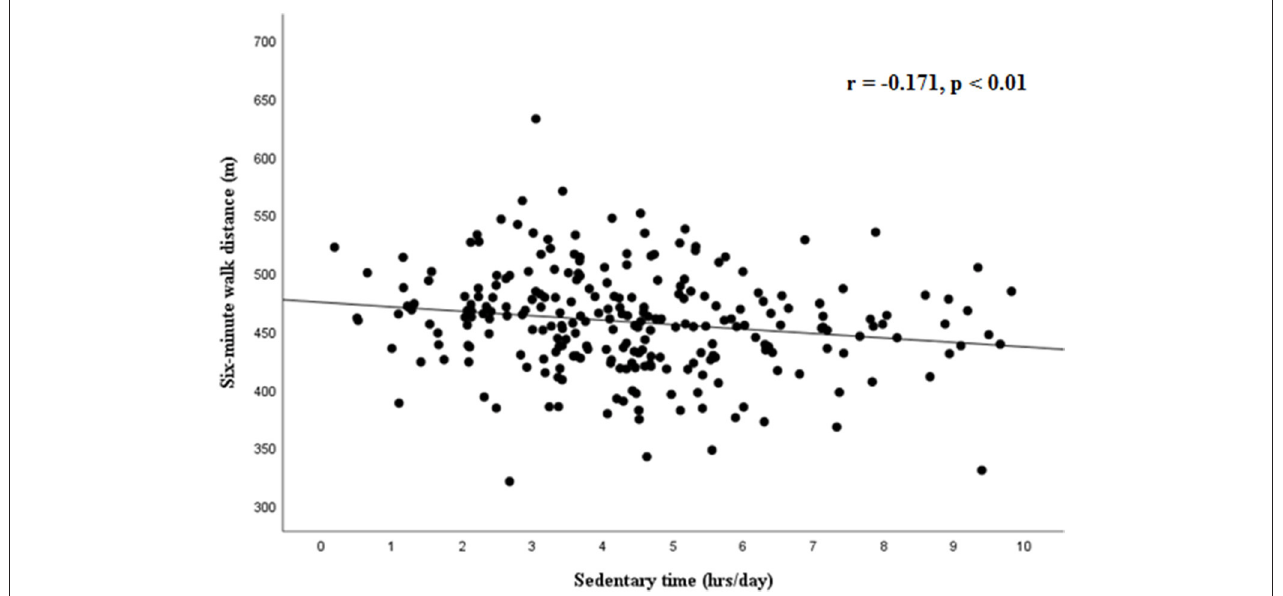
FIGURE 3 | Partial correlation between six-minute walk distance and sedentary time, controlling for age and height.